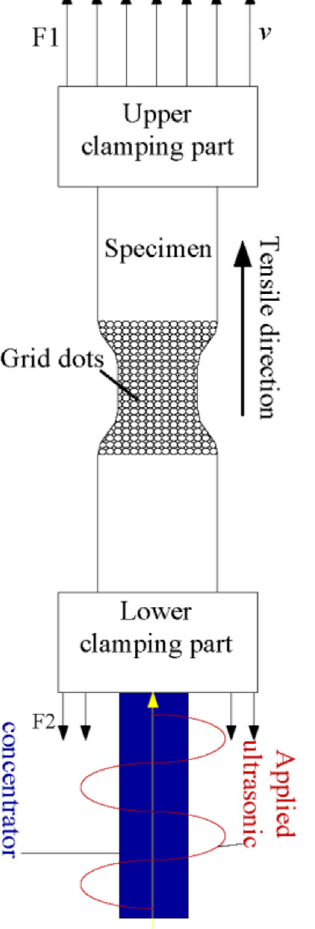
Fig. 3. Uniaxial tensile experimental principle of forming limit based on ultrasonic vibration.